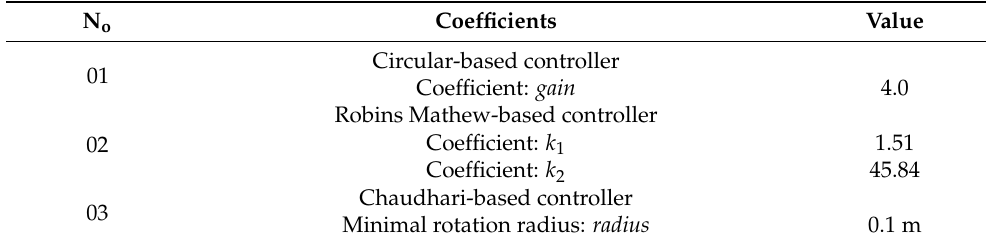
Table 6. Coefficients of the several controllers.